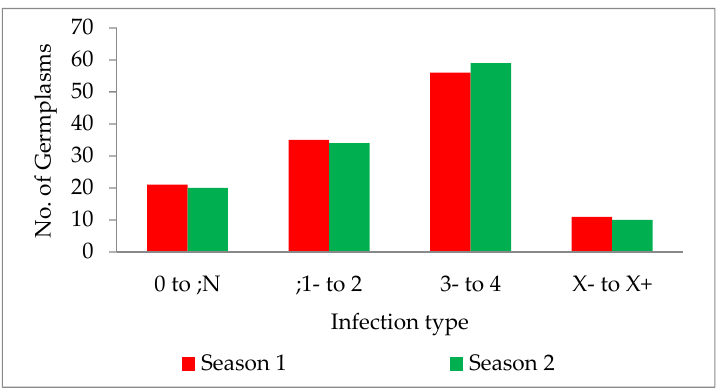
Figure 4. Bar graph description of germplasm infection types in two seasons, 2019–2020 and 2020–2021.